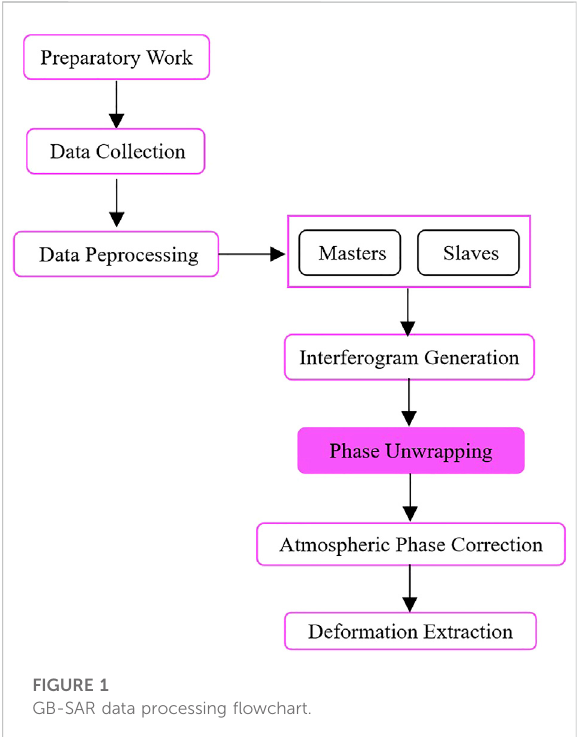
FIGURE 1 GB-SAR data processing fl